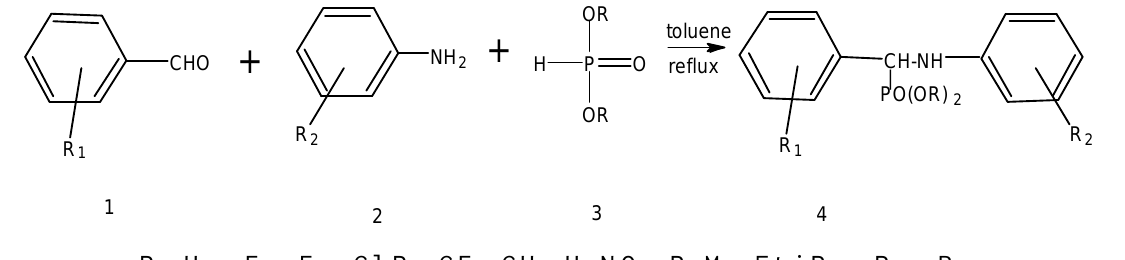
Figure 1. Synthetic scheme.